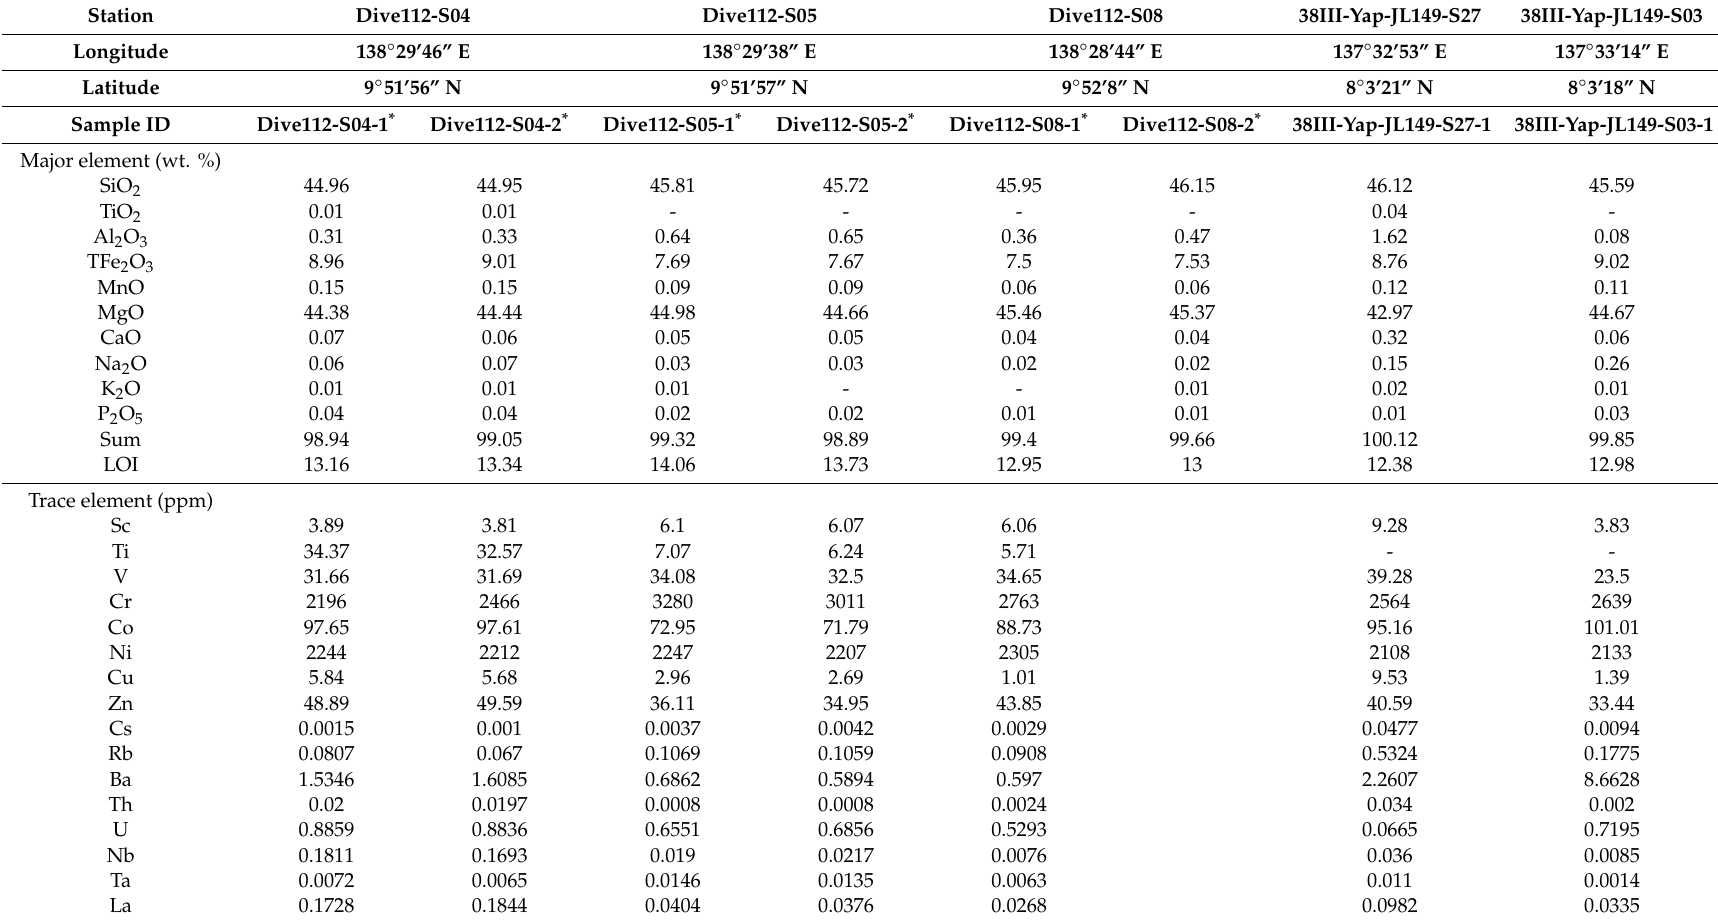
Table 1. Major element (wt. %) and trace element (ppm) concentrations in the bulk-rock